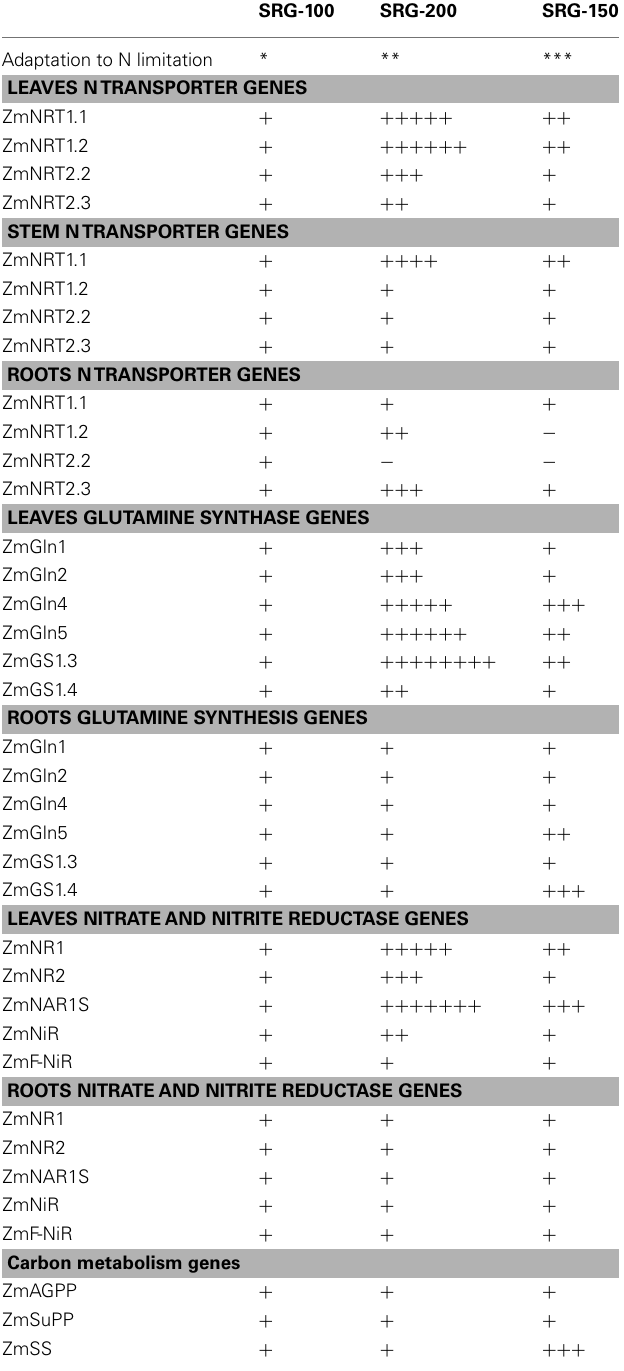
Table 2 | Percentage of the induction ( + ) and the reduction ( − ) of some parameters in the three genotypes growing under N limitation relative the plants of the same genotype growing under optimal N condition.